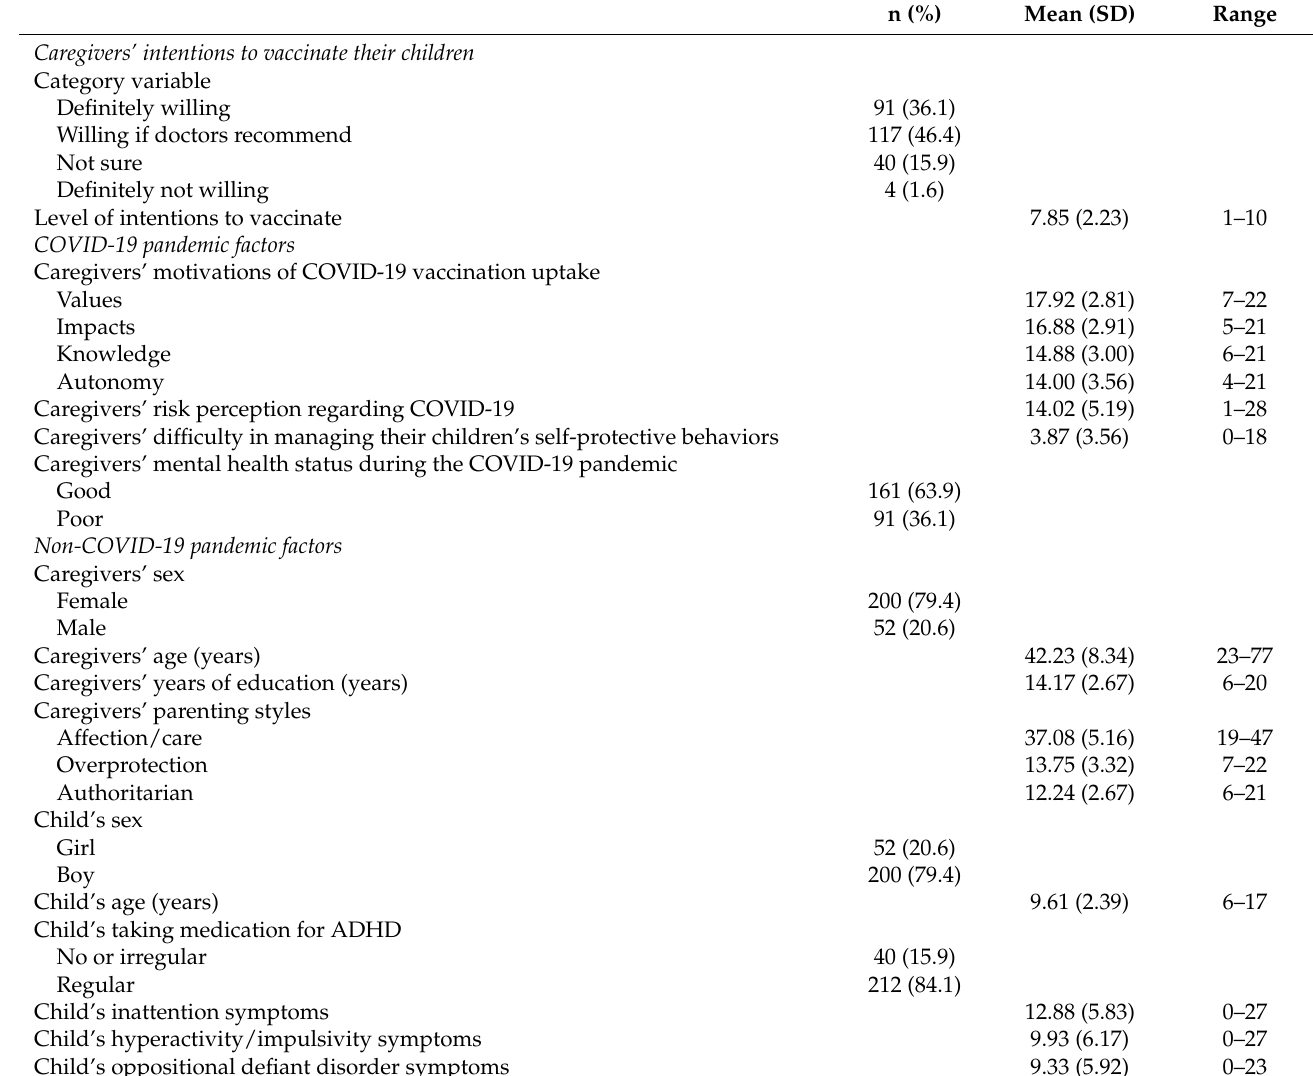
Table 1. The association between caregivers’ intentions to vaccinate their children and COVID-19 pandemic and non-COVID-19 pandemic factors (N = 252). n (%) Mean (SD)